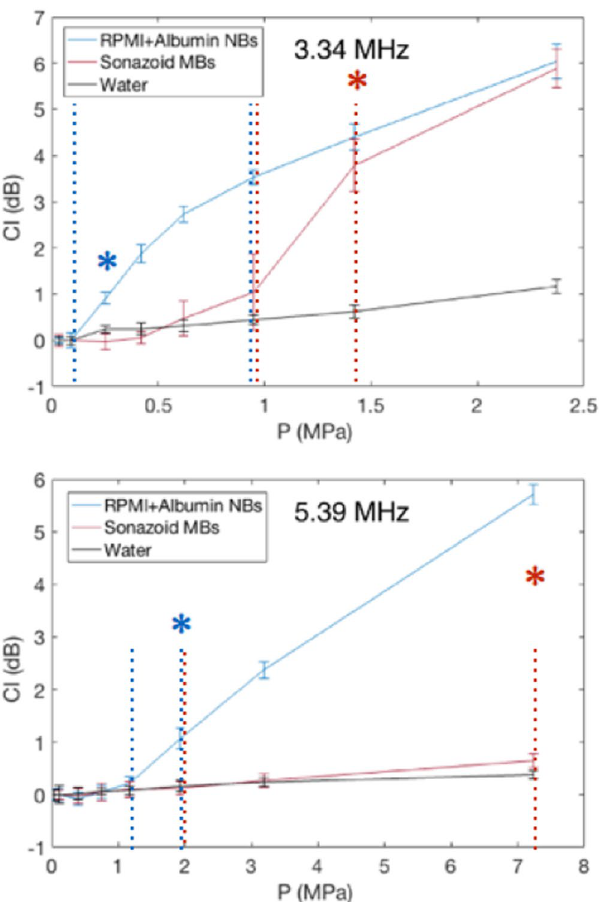
Figure 5. Cavitation-threshold measurements for two types of bubbles at frequencies of 3.34 MHz (top) and 5.39 MHz (bottom). Error bars represent standard deviation of CI over 10 measurements for each pressure level. The blue and red dashed lines (for Albumin NBs and Sonazoid MBs, respectively) represents the pressure interval that is assumed to comprise the cavitation threshold. The asterisk states a statistically the lower pressure parameter with a significant difference relatively to the CI in degassed water (p < 0.01) (it is not displayed for higher pressures for figure clarity). Rheological-parameter determination. Figure 6 illustrates the rheological-parameter determination for the Sonazoid MBs. The region in yellow corresponds to plausible parameter sets (scored 2). This region includes the parameters set of 0.6 N/m and 1.10 − 8 Ns/m, which has been reported for Sonazoid MBs 81 . Fig. 7 illustrates the rheological parameters estimated for the manufactured albumin NBs. The plausible parameters are located on a thin conical region ranging from 0 N/m to 0.06 N/m in surface tension. The corresponding values of dilatational